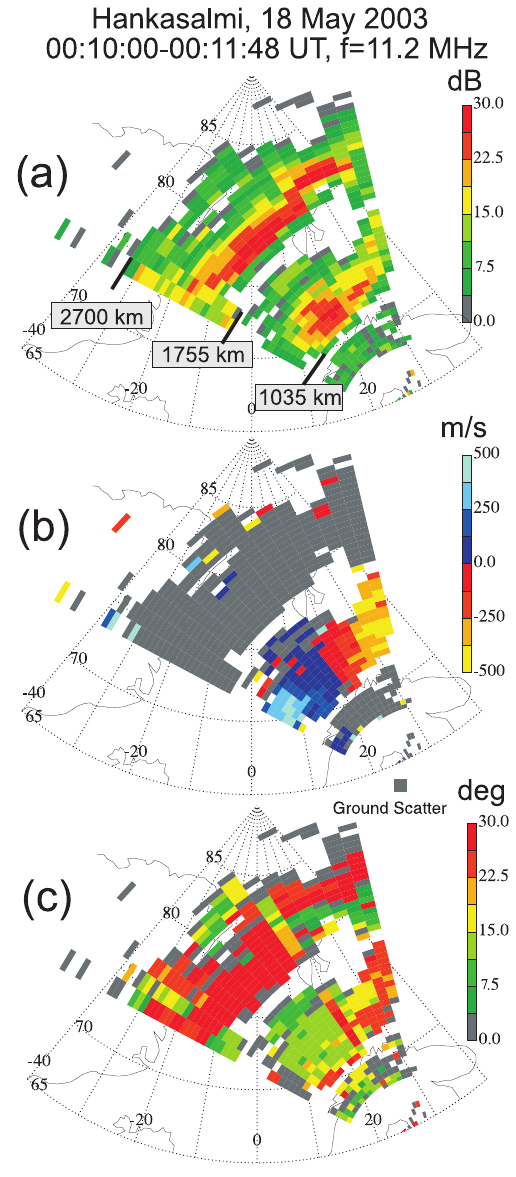
Fig. 2. Hankasalmi echo maps for (a) the power, (b) Doppler ve- locity and (c) elevation angles on 18 May 2003 between 00:10 and 00:12 UT. Frequency of operation was